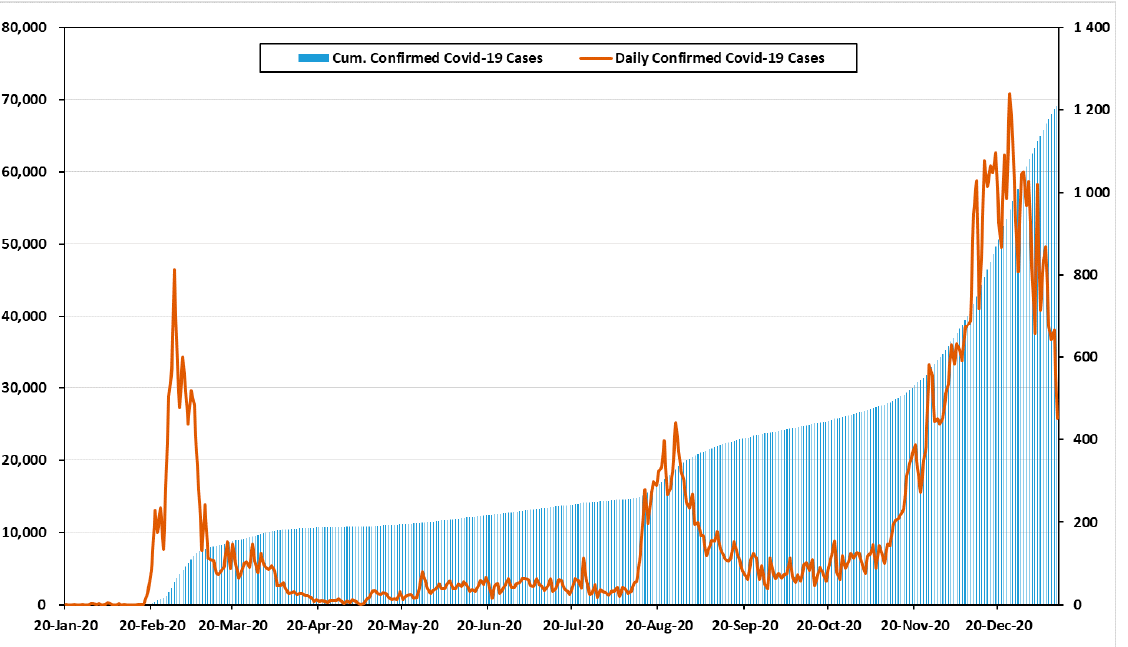
Figure 1. The number of confirmed cases and cumulative confirmed cases of COVID ‐ 19 in Korea in 2020 (including imported cases).